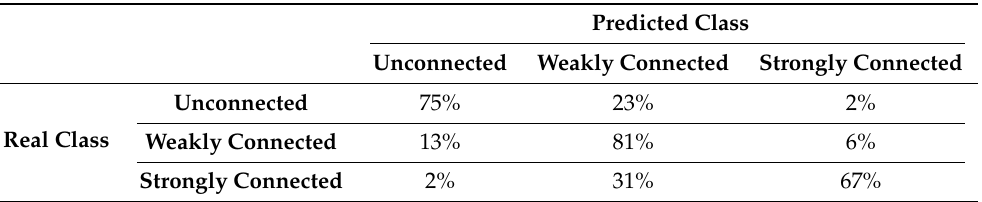
Table 2. Confusion matrix for multi-class classification.